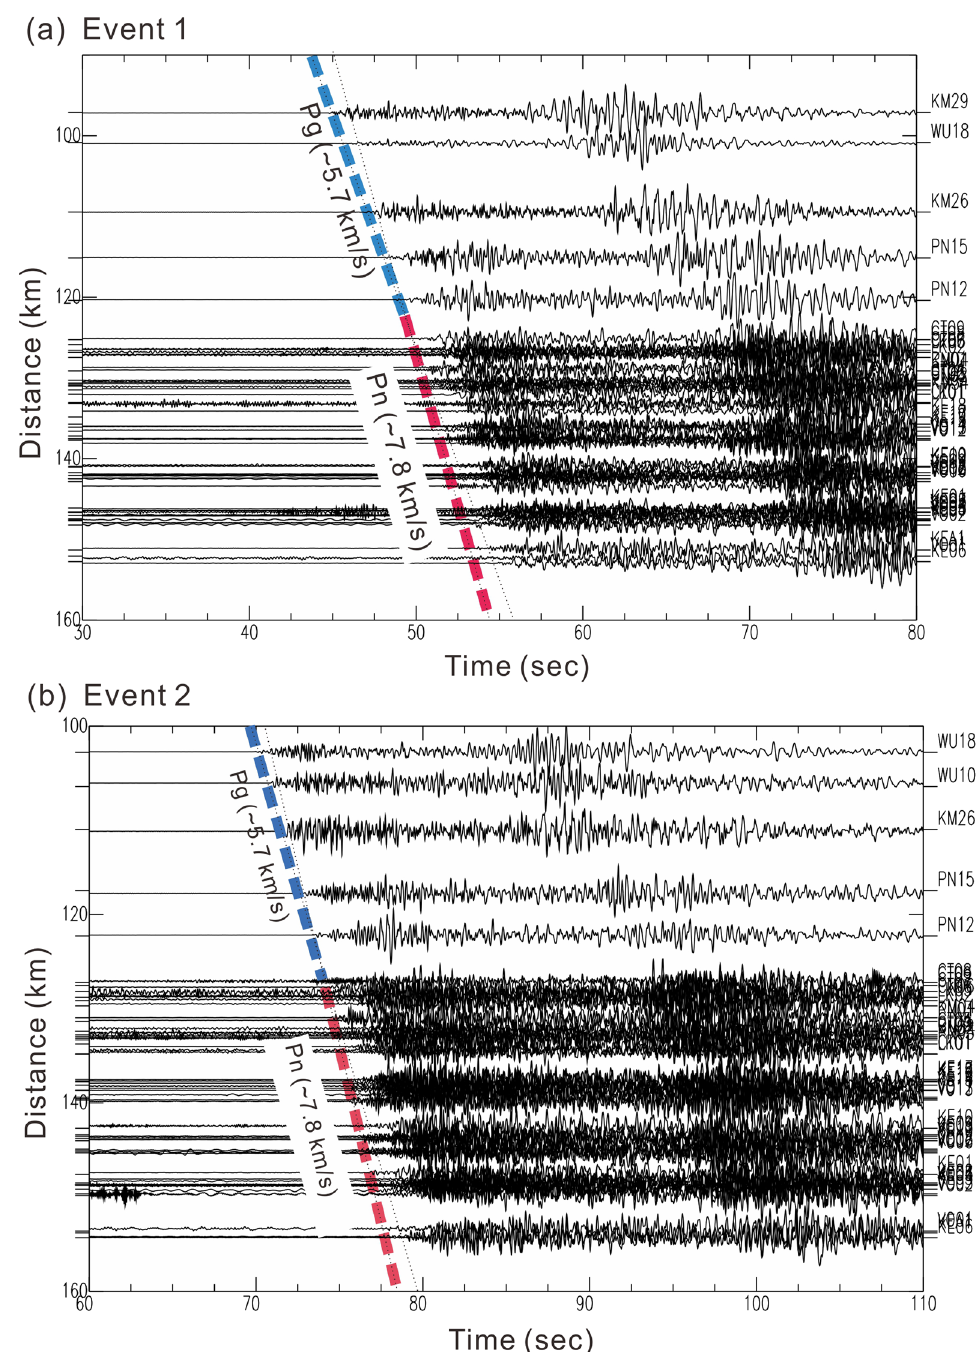
Fig. 3 The vertical velocity seismograms generated by a Event 1 and b Event 2 and recorded by the Formosa Array. The color dashed lines mark the general trend of the first arrivals plotted with the epicentral